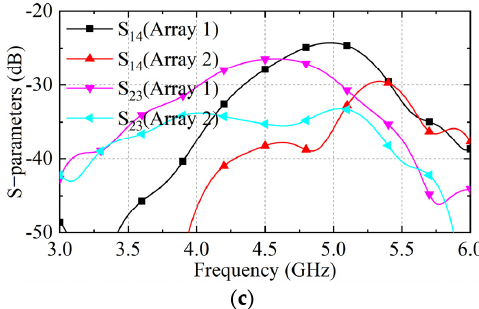
Figure 5. The S parameters of array1 and the one after adding MS and NRMS for array2 and array3, ( a ) the S 11 and S 31 , ( b ) S 22 and S 42 , and ( c ) S 14 and S 23 .